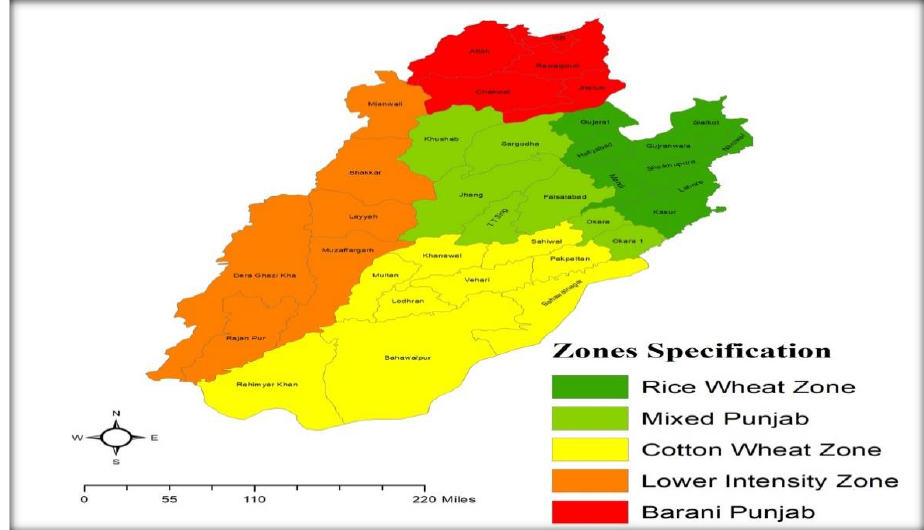
Figure 1. Spatial Map of Agro-Climatic Zones of Province Punjab, Pakistan.